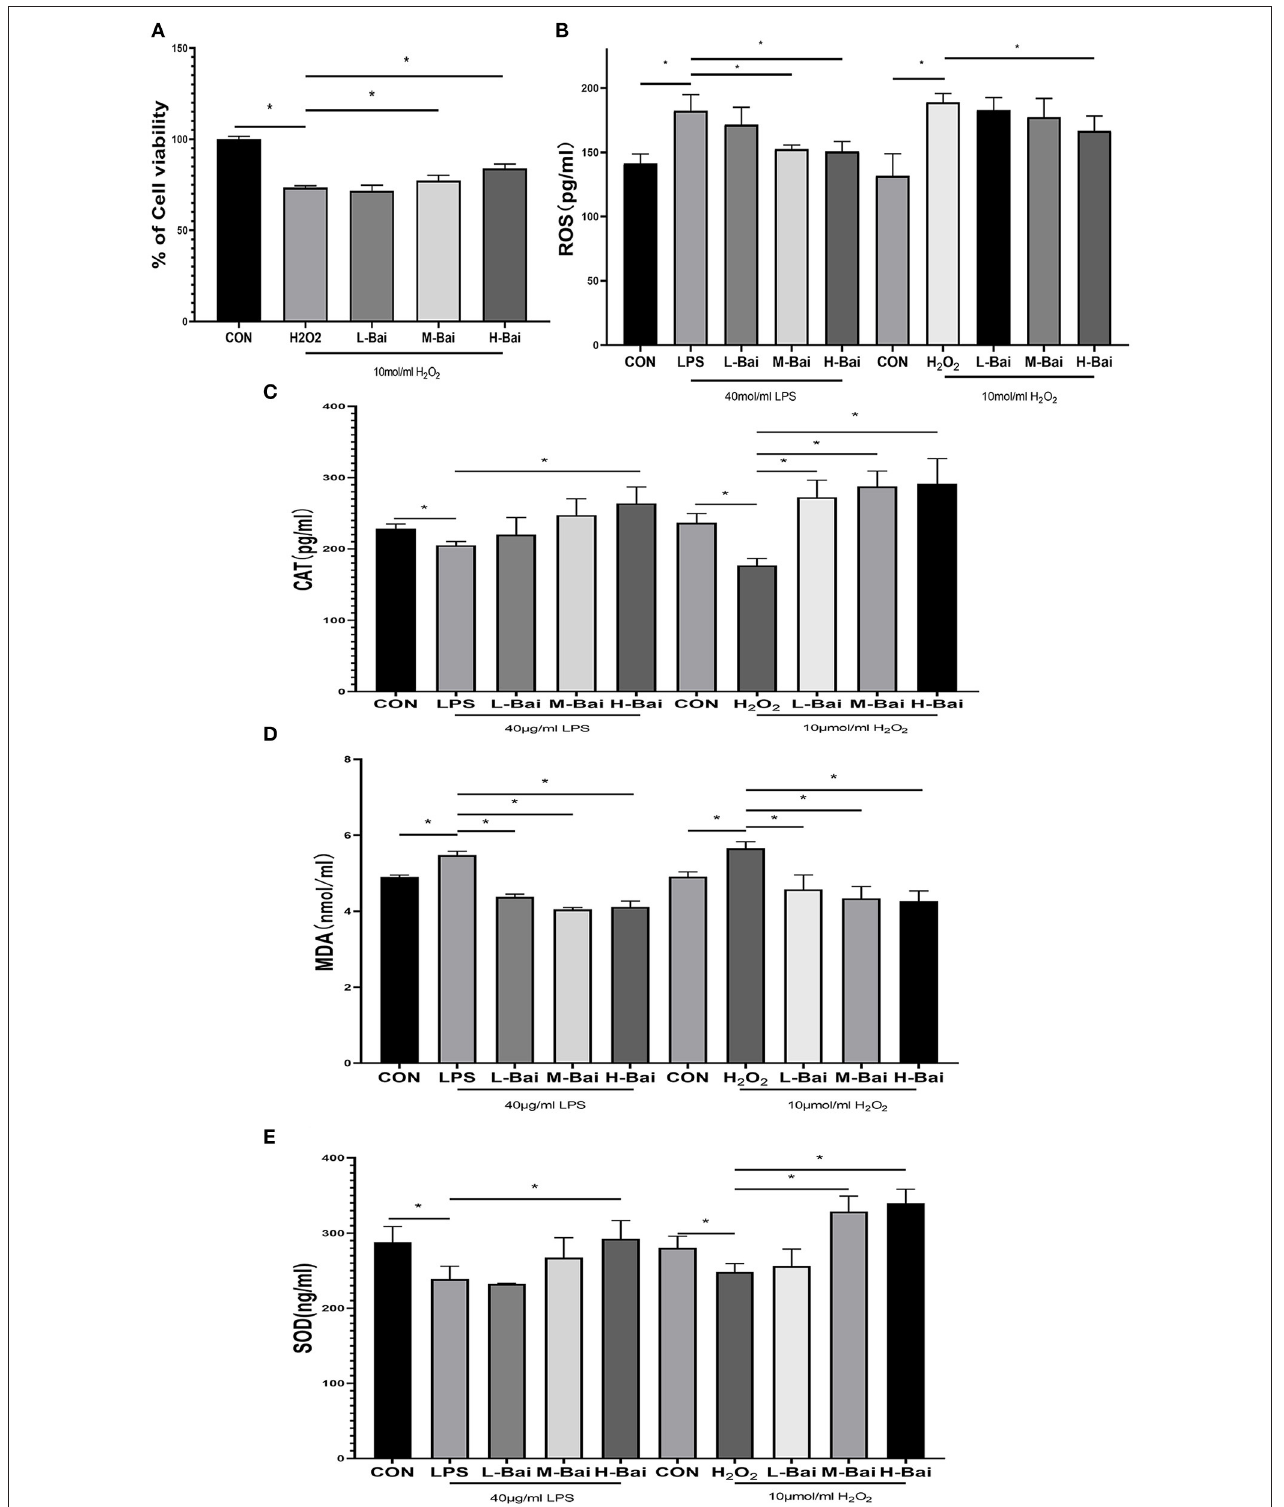
FIGURE 4 | Effects of baicalin on anti-oxidant enzymes and oxidative indices in LPS-stimulated IPEC-J2 cells. H 2 O 2 stimulation decreased the viability of IPEC-J2 cells, and this effect was alleviated by baicalin pretreatment (A) . Effect of baicalin ROS (B) , SOD (C) , CAT (D) , and MDA (E) levels in IPEC-J2 cells stimulated with LPS and H 2 O 2 . Data are presented as the mean ± SEM ( n = 3 per treatment, * p < 0.05 compared with the model group). CON, control; L-Bai, low-concentration baicalin; M-Bai, middle-concentration baicalin; H-Bai, high-concentration baicalin.